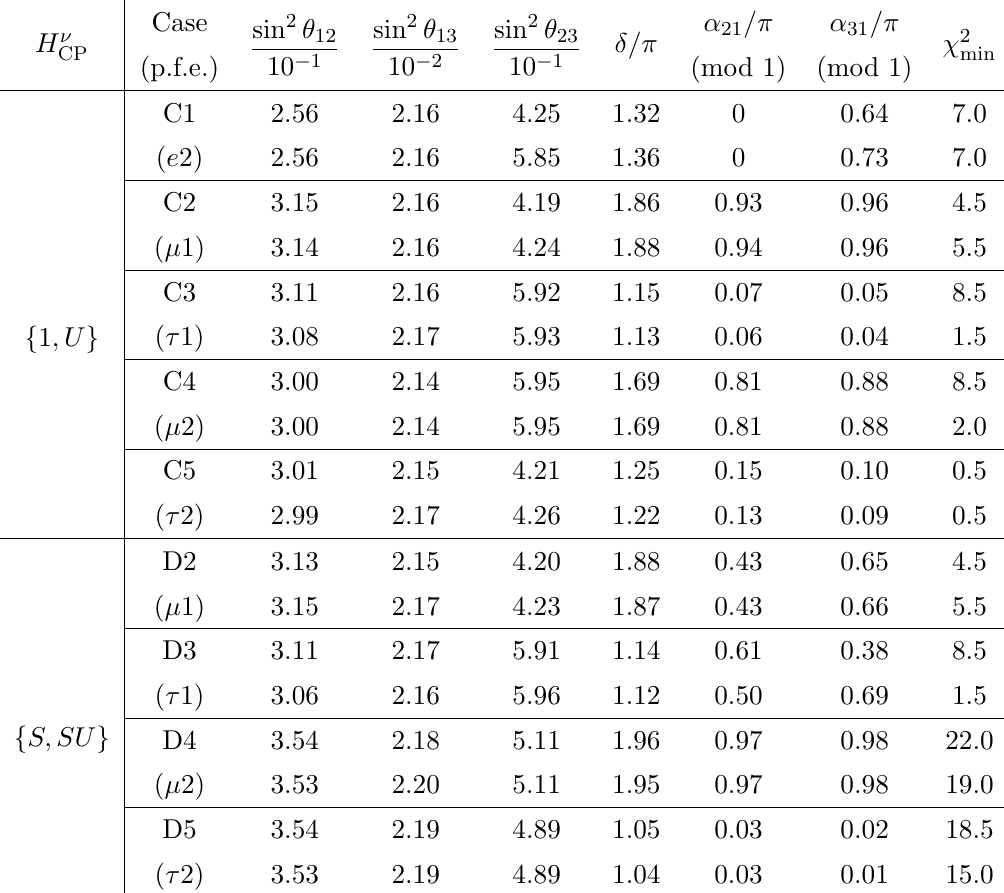
and G (cid:23) = Z g (cid:23) (cid:2) H (cid:23) with f g e ; g (cid:23) g = f TU; U g . 2 2 CP